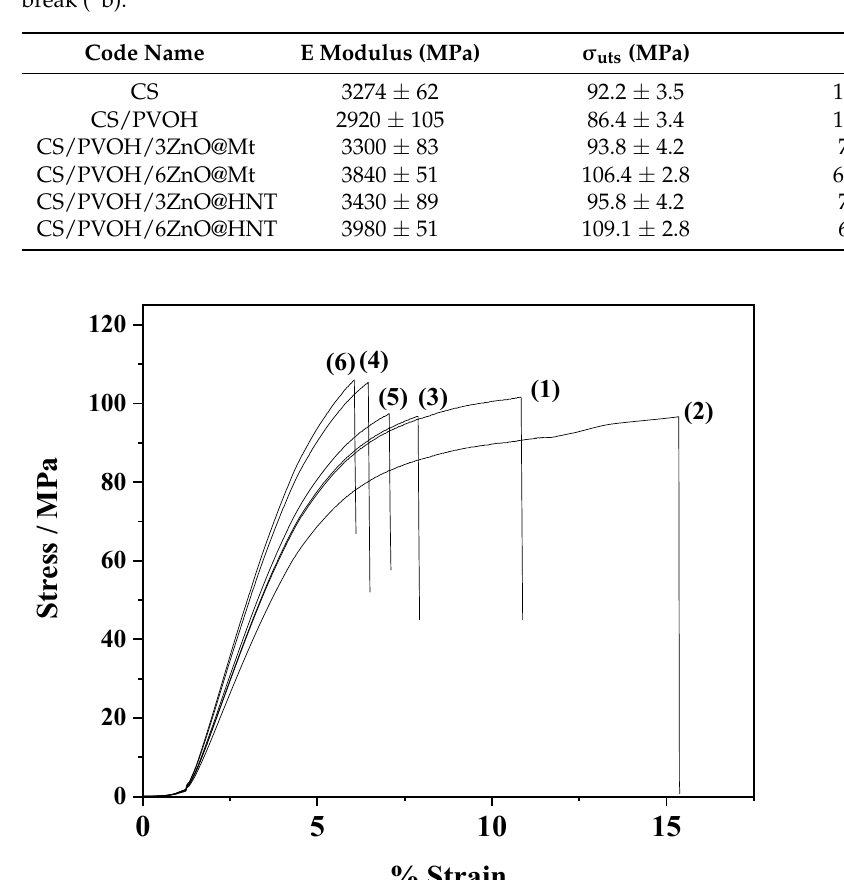
Figure 7. Stress–strain curves of pure CS film (1), CS/PVOH film (2), CS/PVOH/3ZnO@Mt film (3), CS/PVOH/6ZnO@HNT film (4), CS/PVOH/3ZnO@Mt film (5), and CS/PVOH/6ZnO@HNT film (6).